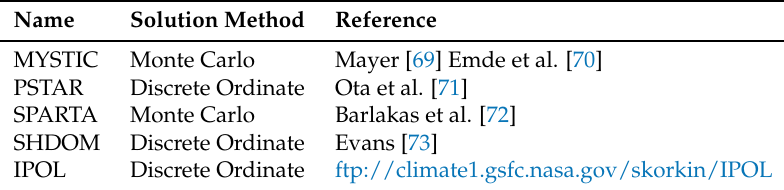
Table A1. Benchmark intercomparison polarized radiative transfer